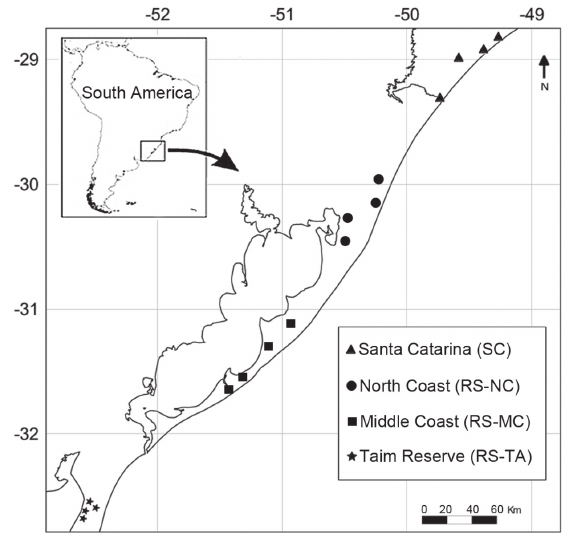
Figure 1 - Location of the 16 sampling sites and classification into four climatically defined subregions in the South Brazilian coastal